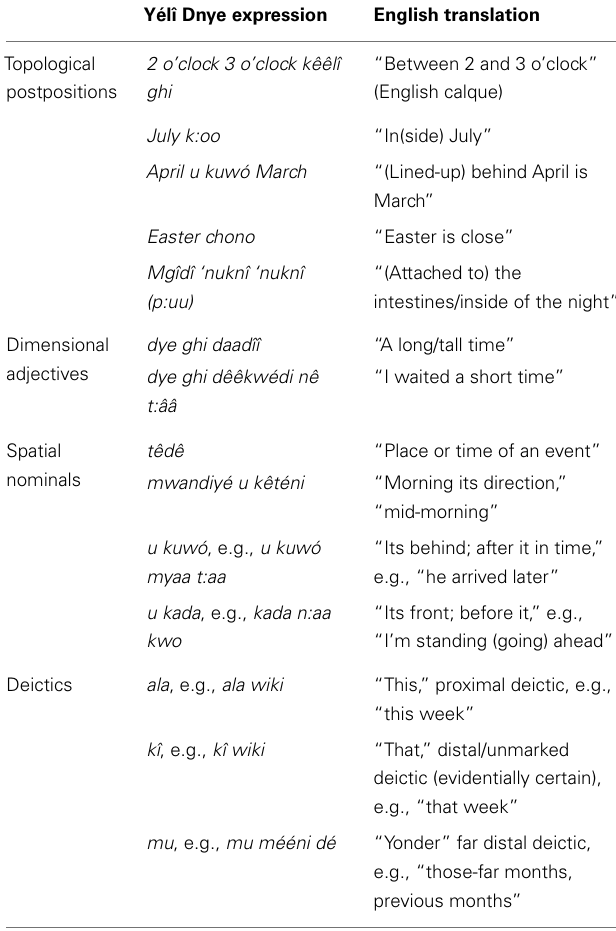
Table 2 |Tense oppositions in different moods and aspects.